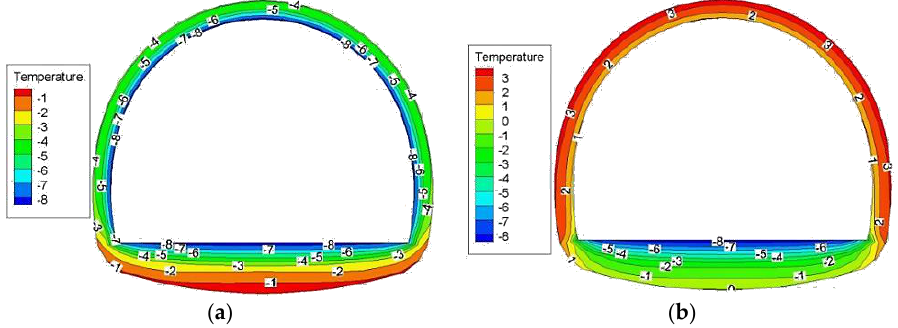
Figure 11. Average temperature contours in December of the secondary lining and lane plate: ( a ) without heat-insulating layer and ( b ) with heat-insulating layer (cross-section K0 + 015).